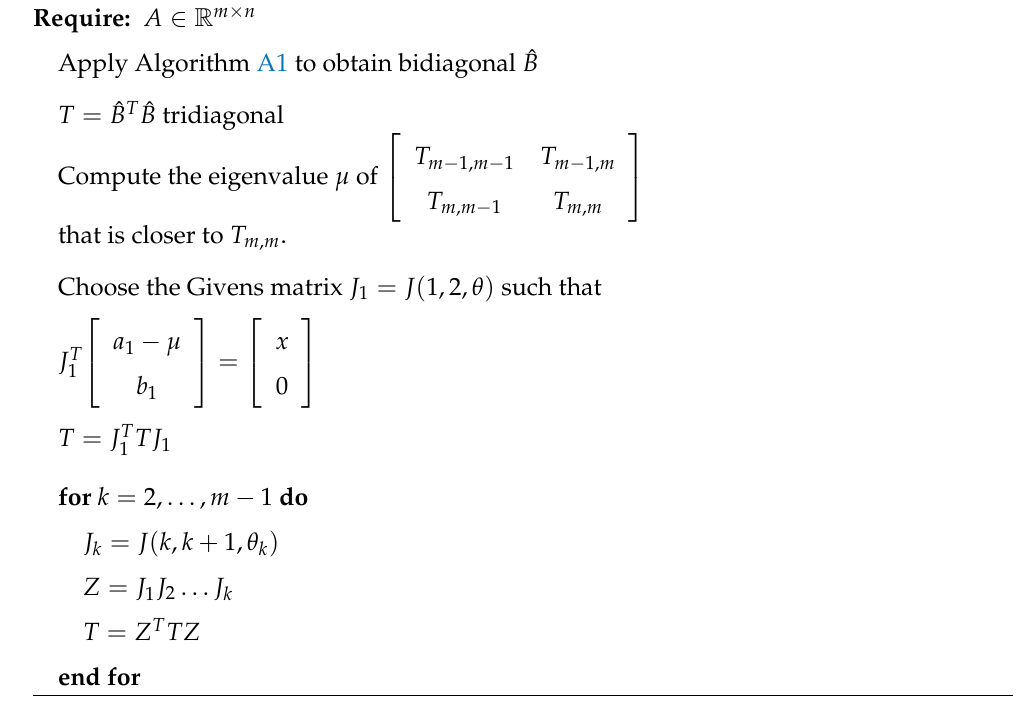
Algorithm A3 QR iteration with implicit